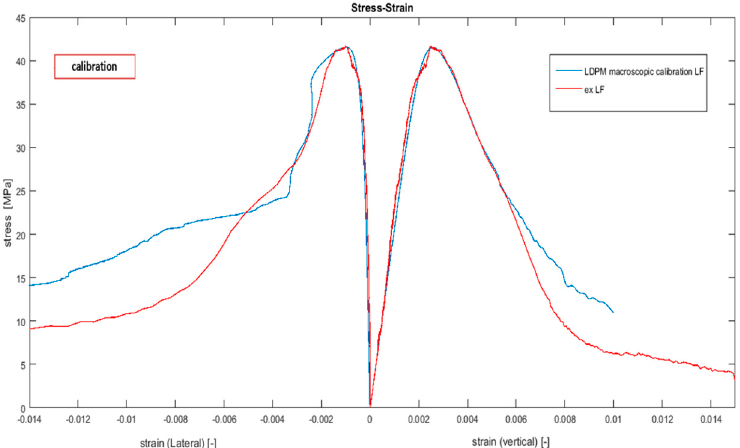
Figure 14. Uniaxial compression test experimental and numerical results using macroscopic calibration (the blue line represents the average of three different particle placements of the LDPM numerical simulation, and the red curve represents the average of three different specimen tests).